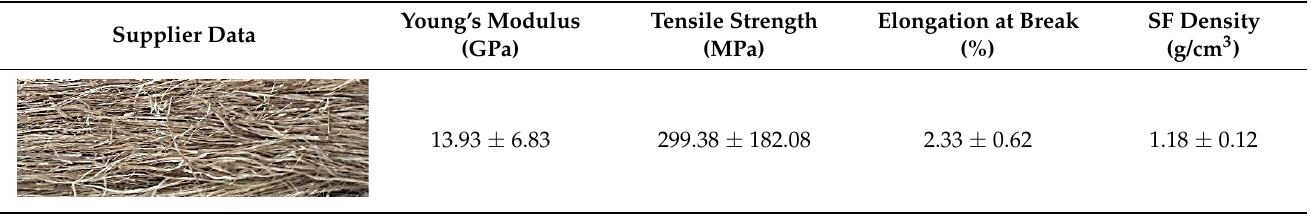
Table 1. Mechanical properties of the nettle fiber.